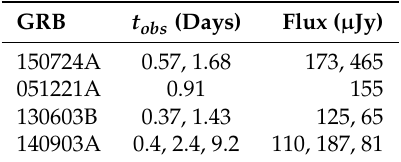
Table 1. Radio afterglow detections of short